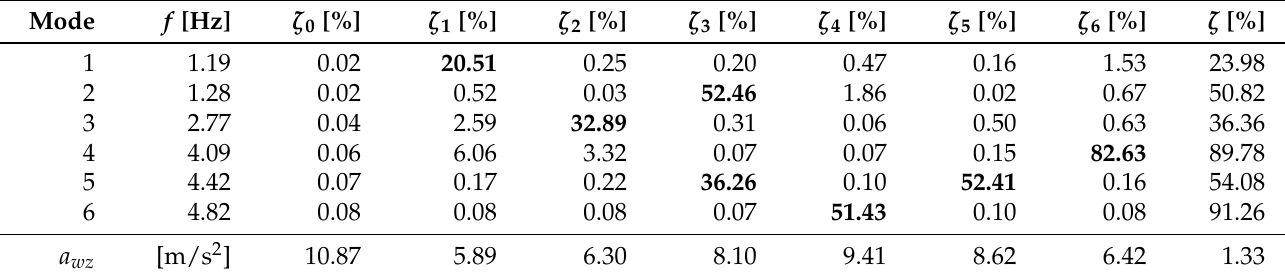
Table 2. The effect of suspension damping on the modal damping ratio of the tractor. Highlighted in bold the modal damping ratios of modes that are more affected by each